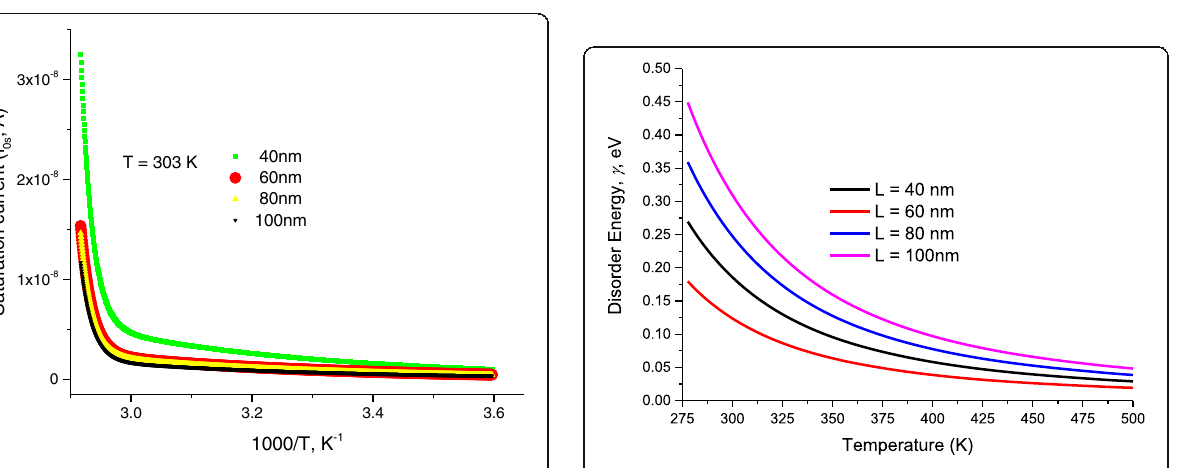
Fig. 6 The disorder energy of DNA molecule for different lengths estimated after fitting of experimental data to Eqs. (5 –